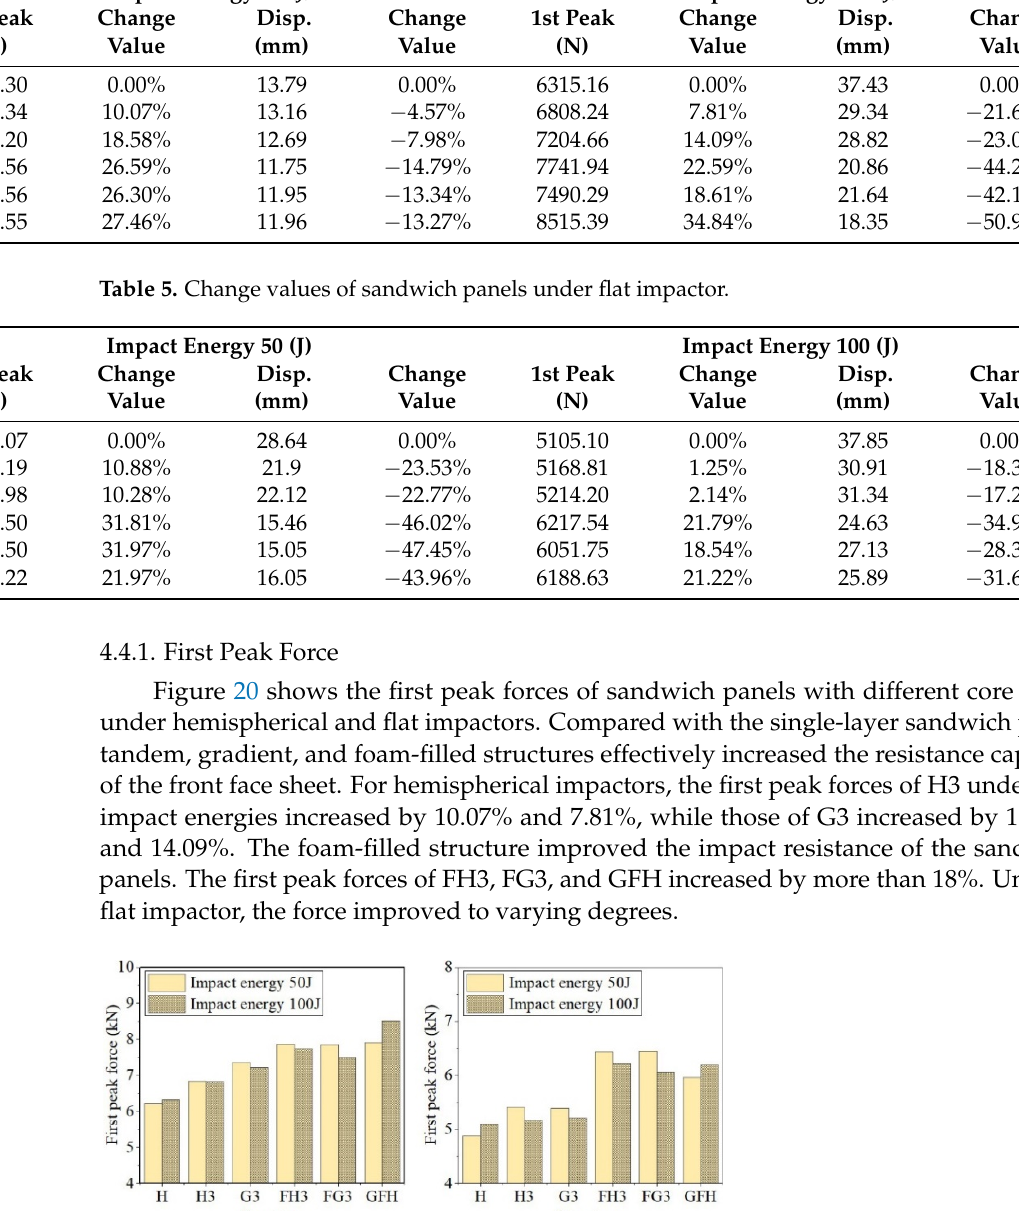
Figure 21. Maximum impact displacement of various panels with hemisphere impactor. (a) Impact energy at 50J. (b) Impact energy at 100J.